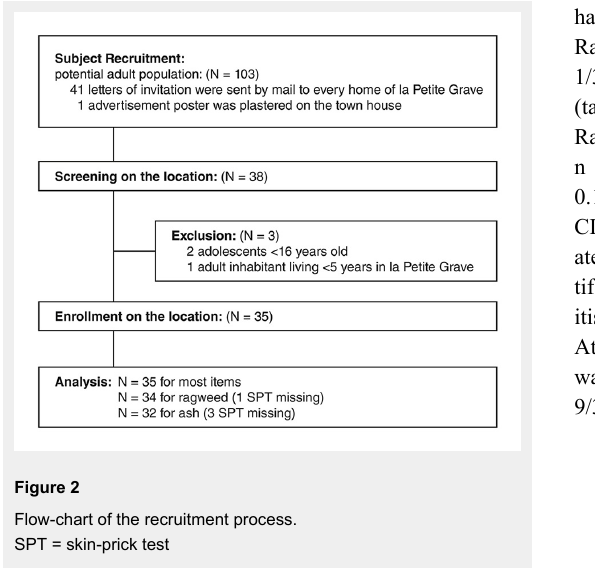
Flow-chart of the recruitment process. SPT = skin-prick test